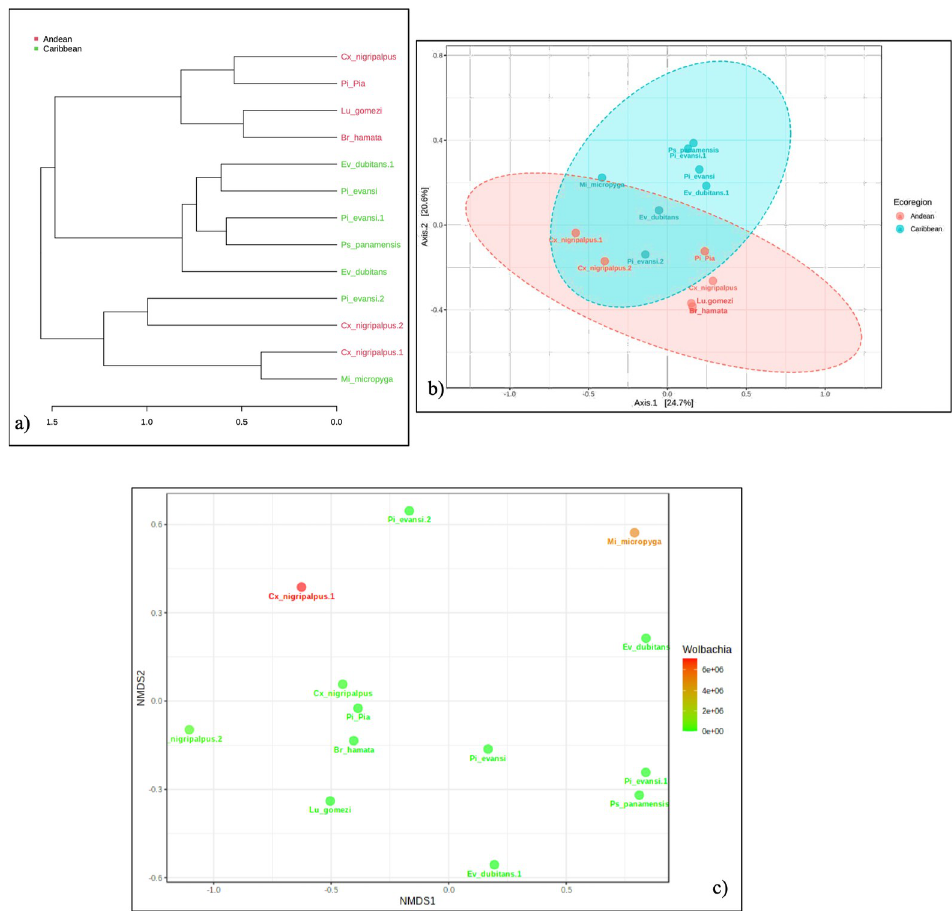
Fig 8. β -diversity analysis (between groups) of microbial communities associated with the groups of samples established of sand flies and Culex nigripalpus found with endosymbiont in several ecoregions from Colombia. a) Hierarchical clustering analysis of ASVs at the genus level. b) Principal Coordinate Analysis (PCoA) with ASVs at the genus level (Weighted Unifrac Distance, PERMANOVA, F = 2.4744; R2 = 0.18363; p-value = 0.007). c) Beta-diversity visualized using Non-metric Multidimensional Scaling (NMDS). The plot was obtained with Bray-Curtis Dissimilarity distances (PERMANOVA, F = 1.1429; R2 = 0.094118; p-value = 0.324; [NMDS] Stress = 0.11348).